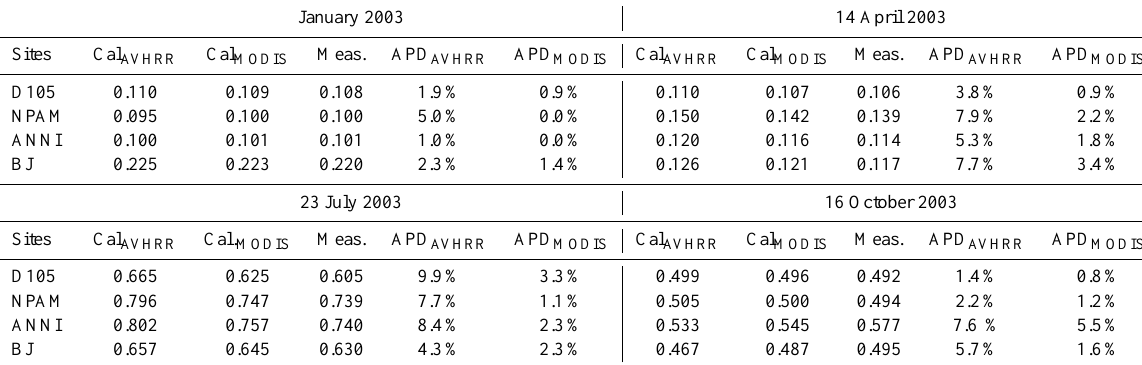
Table 3. Comparison of the derived evaporative fraction 3 from AVHRR (Cal AVHRR ) and MODIS (Cal MODIS ) vs. the values measured (Meas.) at the Tibetan Plateau with absolute percent difference (APD) in 2003.